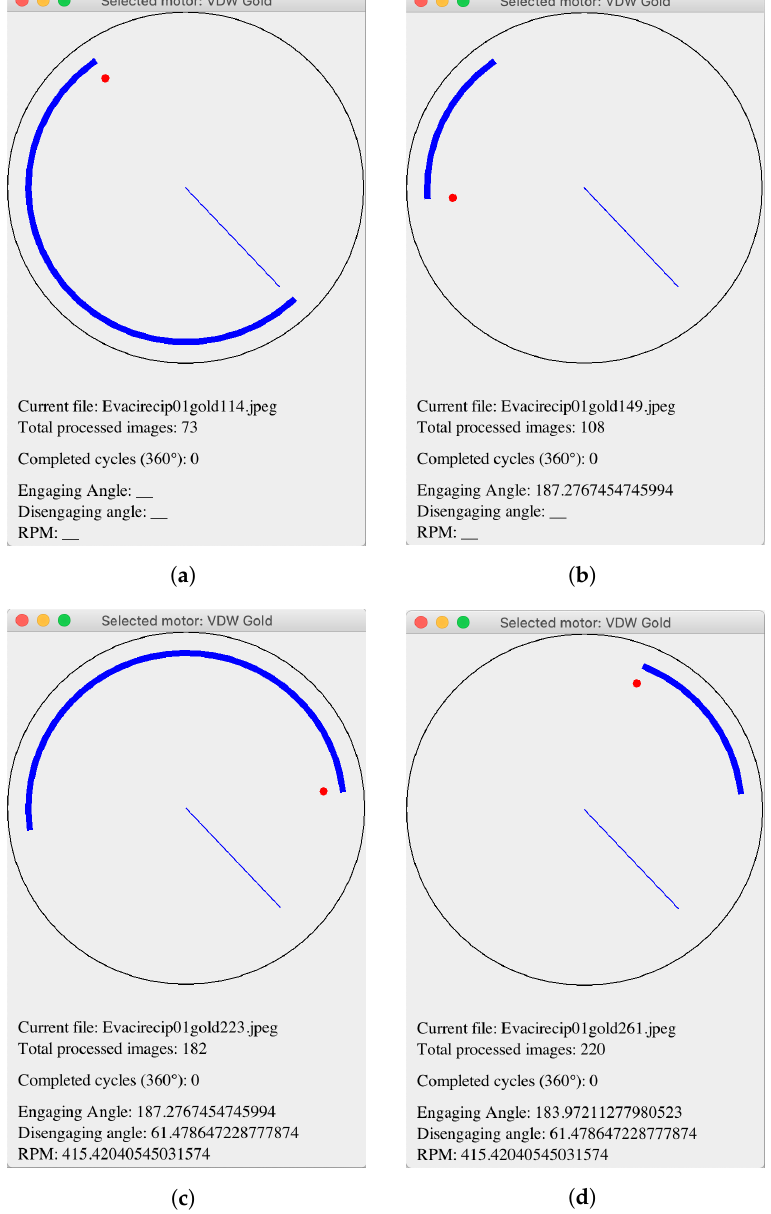
Figure 4. Screenshots of the implemented visual module for the VDW Gold motor: ( a ) engaging movement from initial position; ( b ) disengaging movement (opposite); ( c ) second engaging movement; ( d ) finalizing the second movement